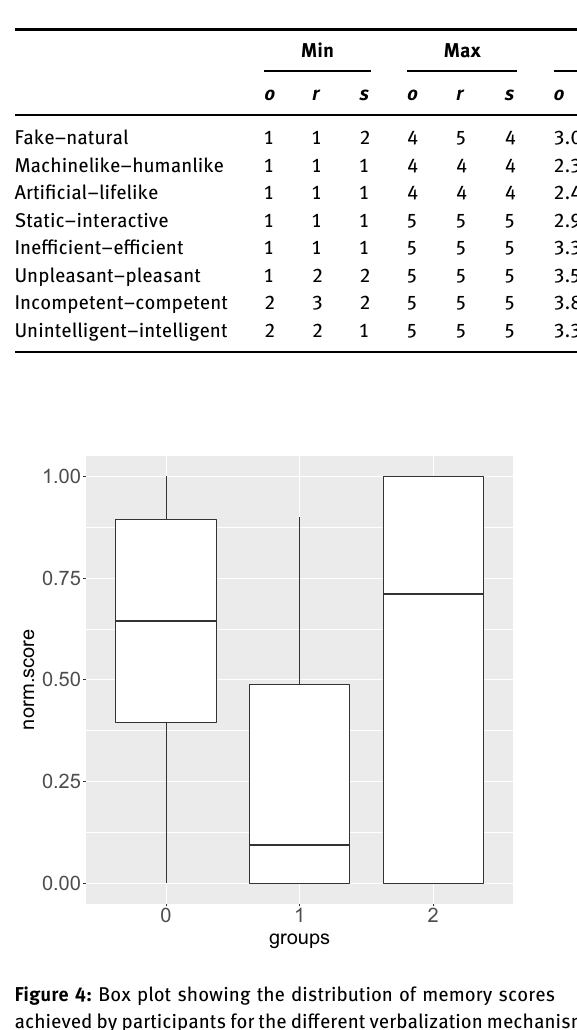
Table 4: Summary statistics for the questions regarding people ’ s perception of the robots ’ explanations; “ o ” : “ optimal ” mechanism video, “ r ” : “ random ” mechanism video, and “ s ” : “ single ” mechanism video